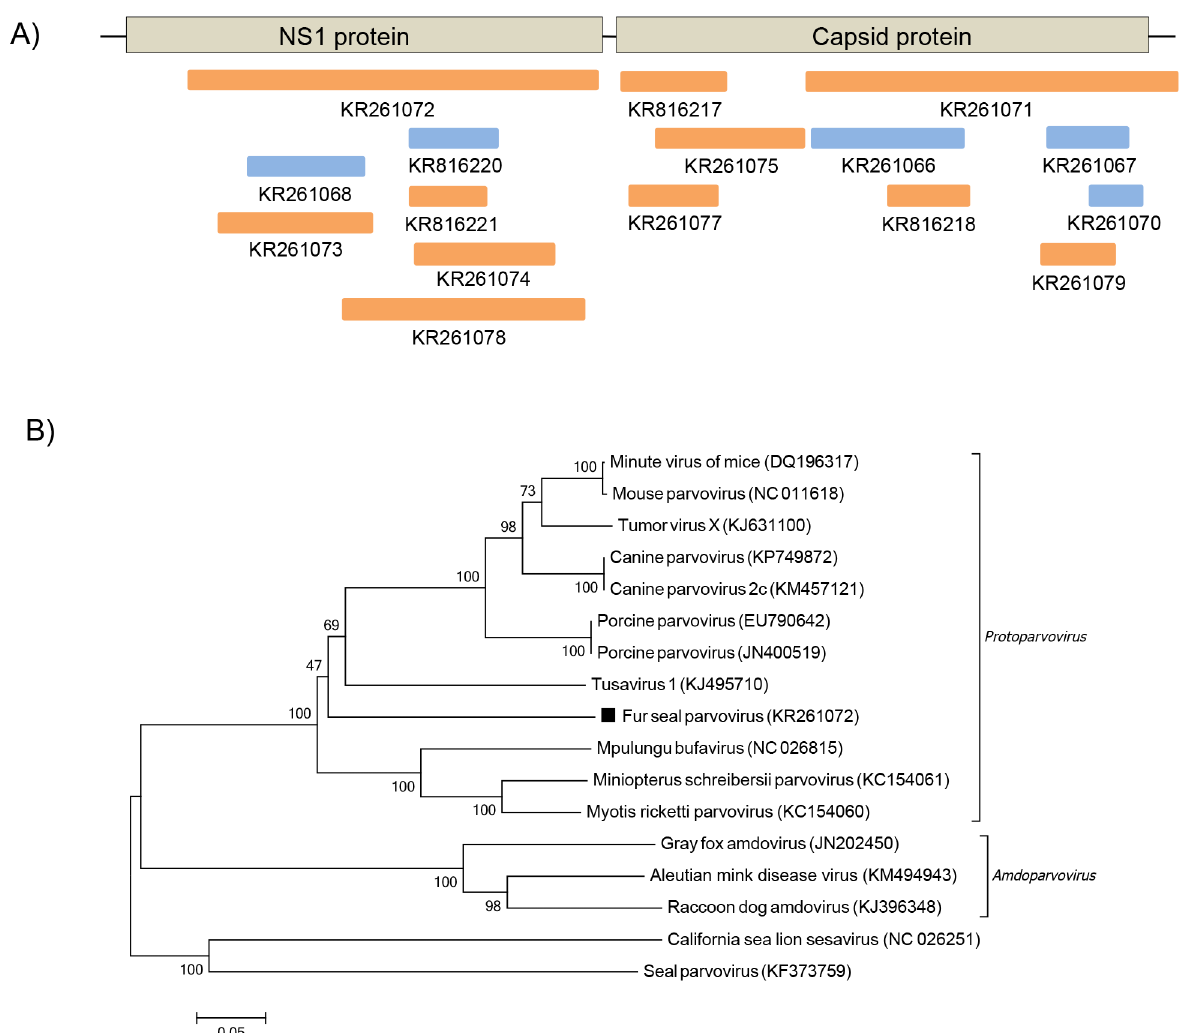
Fig 4. Phylogenetic analysis of fur seal parvovirus. (A) Schematic representation of the genome of parvoviruses using as example the tusavirus (~4.4 kb). The blue bars represent the contigs from South American fur seal and the orange bars represent the contigs from Subantarctic fur seal. (B) Neighbor- joining phylogenetic tree based on the alignment of partial amino acid sequences (261 aa) from the NS1 protein of 17 parvoviruses. Seal parvovirus and California sea lion sesavirus were used as outgroup. The parvovirus sequence from Subantarctic fur seal identified in this study is labeled with a black square. The GenBank accession numbers of the viral sequences are shown in